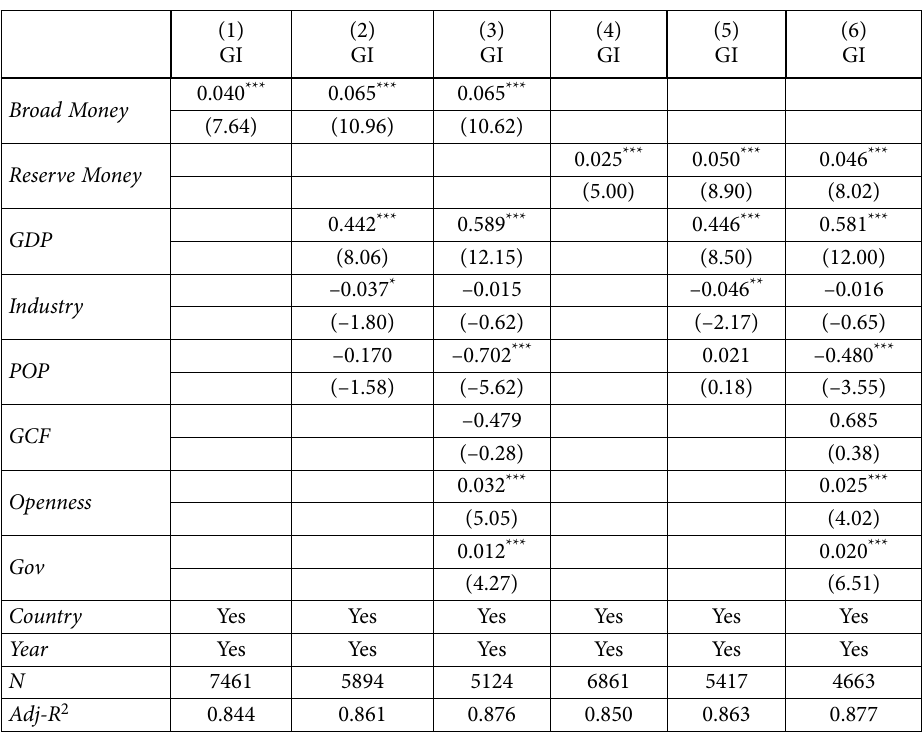
Table 3. Baseline regression